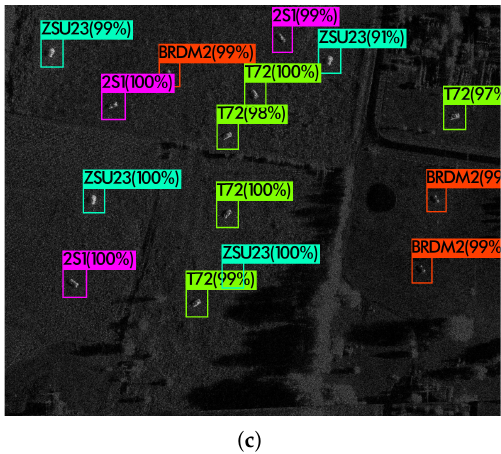
Figure 11. The presentation of target detection of YOLOv4 under EOC by using different datasets: ( a ) MF dataset; ( b ) ˆX C dataset; ( c ) ˜X C dataset.